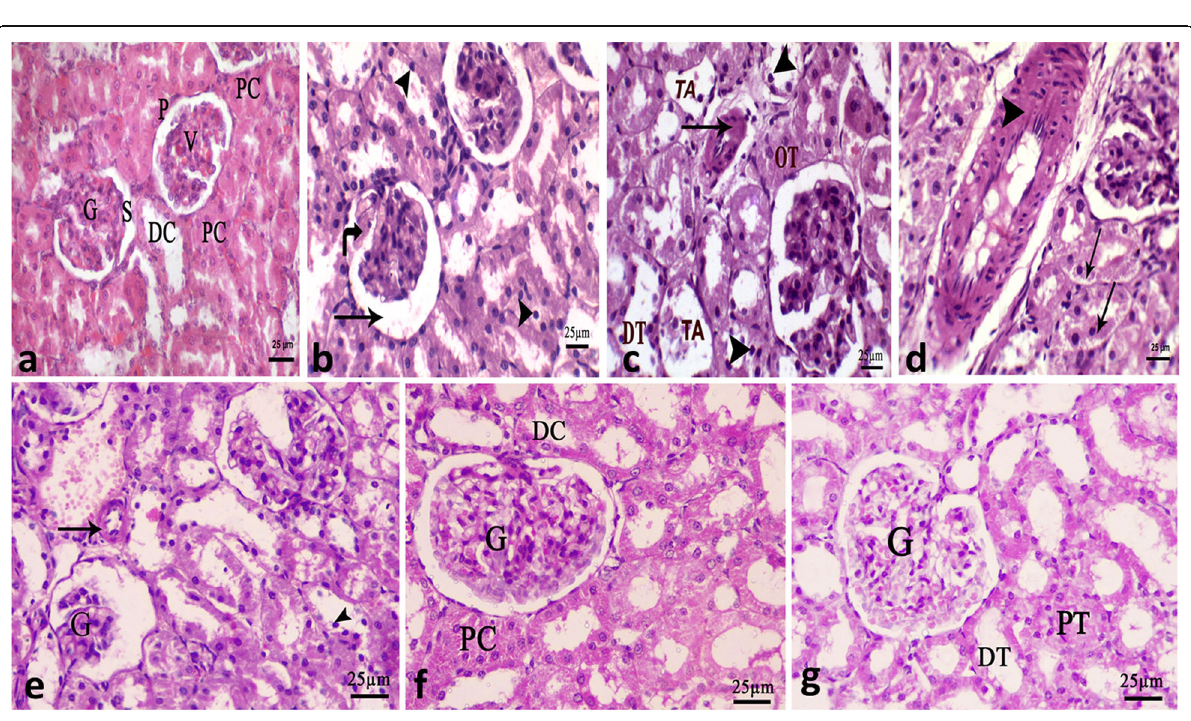
Fig. 3 H&E stained renal cortex sections at magnification × 400, bar 25 μ m. a Control group shows normal structure of glomeruli (G) with Bowman ’ s spaces (S) which is lined by visceral (V) and parietal (P) cells. Proximal tubules (PC) and distal tubules (DC) are also showed. b – d Renal cortex of diabetic nephropathy group ( b ) has distorted glomeruli with expanded Bowman space (arrow). The glomeruli showed foci of hyalinosis and eosinophilic deposits (curved arrow) while tubules show dark stained nuclei (arrows heads). c Some tubules are atrophied (TA); others are dilated (DT), and some are obliterated (OT). d Blood vessels have marked hyalinization (arrow head). Dark nuclei and a vacuolated cytoplasm (arrow) are seen within tubules. e Fibroblast group shows distorted shrunken glomeruli (G); blood vessels showed hyalinosis (arrow), and tubules show dark stained nuclei (arrow head). f ADMSC group shows marked improvement in the glomeruli (G), proximal tubules (PT), and distal tubules (DT). g Culture media group shows the glomeruli (G), proximal tubules (PC), and distal tubules (DC) appear nearly similar to that of the